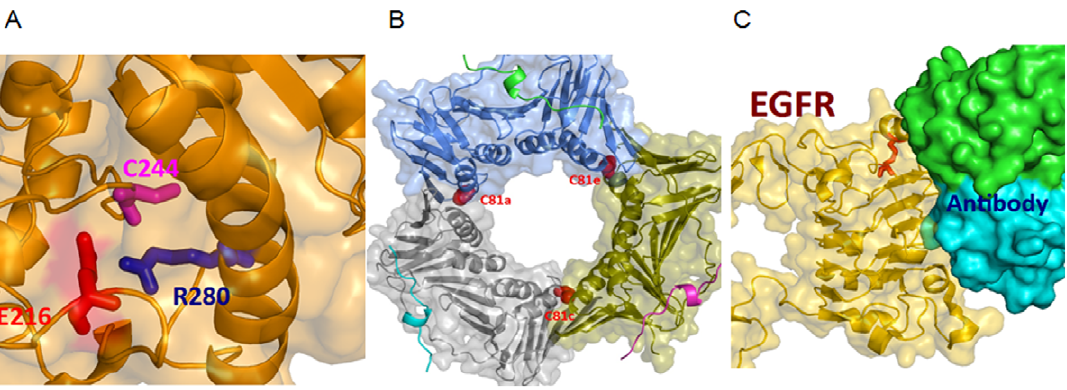
Figure 6. Crystal structure of the representative protein-SNOs. A ) An example of a buried S- nitrosylation site in a crystal structure of the human protein disulfide-isomerase, PDIA3 (PDB code 3F8U), with positively charged (R280) and negatively charged (E216) residues in direct spatial proximity of the nitrosylated cysteine (C244). B ) An example of an S- nitrosylation site in direct contact with a ligand and thus likely disrupting/ affecting ligand binding upon nitrosylation. One of such examples is EGFR, which is shown here in complex with the monoclonal antibody inhibitor cetuximab (PDB structure 1YY9). Binding of the antibody partially occludes the ligand-binding site in EGFR and keeps it in an inactive conformation. As can be seen from the figure, the targeted cysteine (highlighted using red stick model) directly supports the protein interaction interface in EGFR, suggesting that S- nitrolysation may attenuate its interactions with ligands and inhibitors. C ) An example of S- nitrosylation site(s) located within protein-protein (oligomerization) interfaces and that thus may disrupt/attenuate complex formation in PCNA and its function in DNA replication. Note that DNA, which occupies the central hole in the PCNA trimer, is not included in this complex (PDB structure 1VYJ). On the other hand, p21 peptides, which mediate regulatory interactions with CDK/cyclin complexes, are shown using cartoon models.